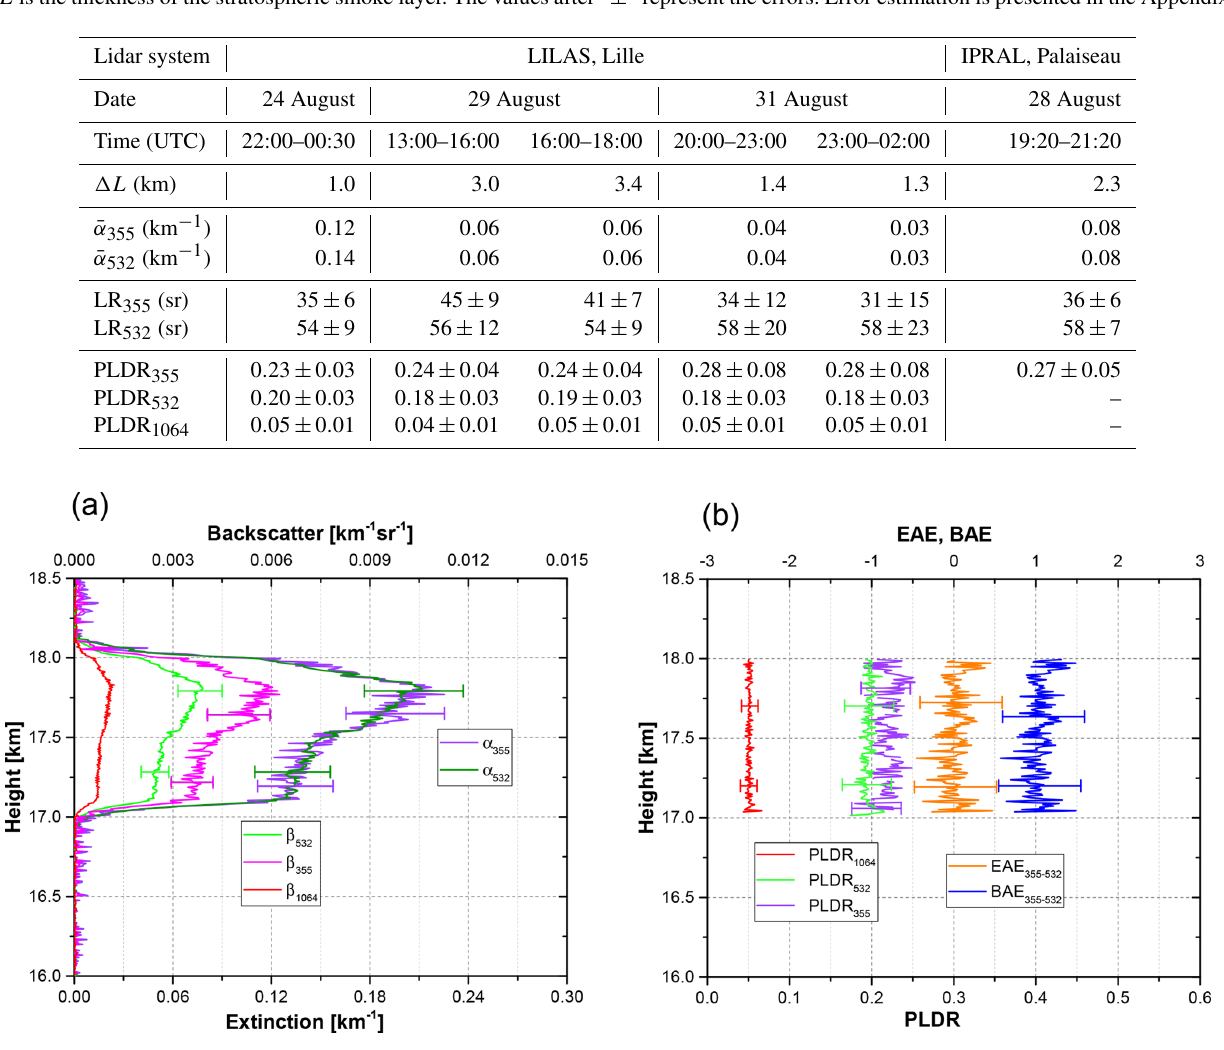
Figure 9. (a) Extinction and backscatter coefficients, (b) particle linear depolarization ratio (PLDR), and the extinction-related Ångström ex- ponent (EAE) and backscatter-related Ångström exponent (BAE) retrieved from LILAS observations between 22:00UTC on 24 August 2017 and 00:30UTC on 25 August 2017 at Lille. The errors of extinction, backscatter coefficient, and corresponding Ångström exponent at 355 and 532nm are attributed to the error of the optical